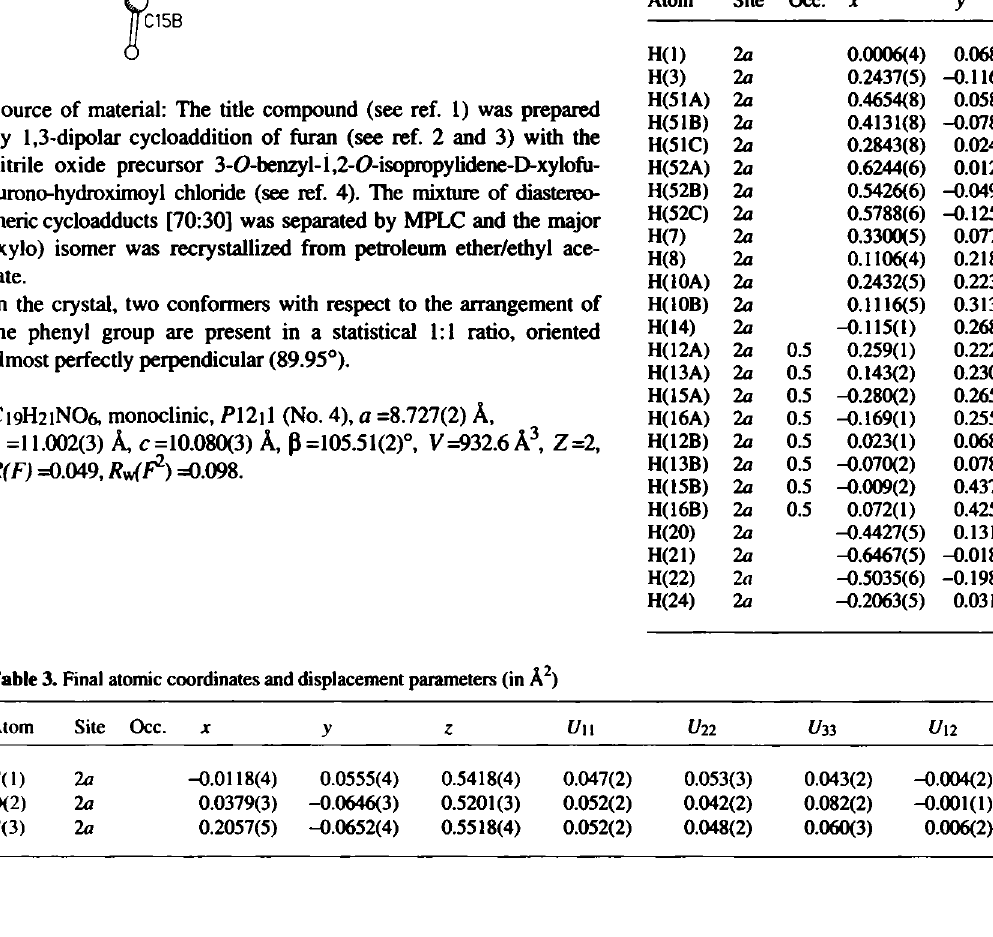
Table 2. Final atomic coordinates and displacement parameters (in Â 2 )